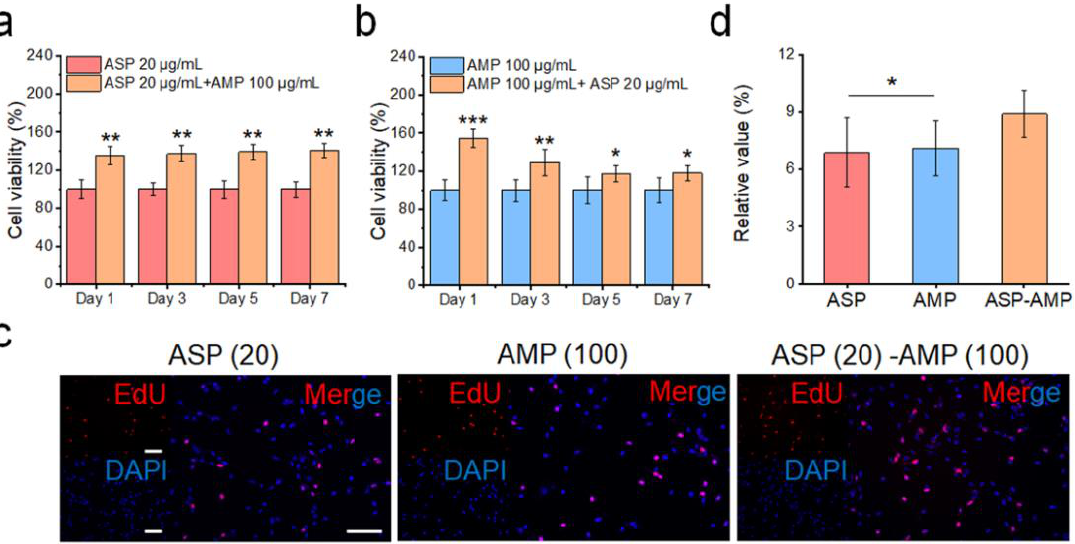
Figure 2. Combined treatment with both ASP and AMP enhanced the proliferation of NCTC clone 1469 cells. ( a ) The cell viability of hepatocytes treated with a combination of ASP and AMP compared to the separate use of ASP ( a ) or AMP ( b ) for 7 days ( n = 3). ( c ) Click-iT EdU proliferation staining of hepatocytes treated with ASP, AMP, and ASP-AMP for 3 days (scale bar = 100 µ m). ( d ) Relative expression rates of positive EdU staining ( n = 3). * p < 0.05, ** p < 0.01, and *** p < 0.001. As shown in the schematic diagram of 70% hepatectomy in mice, after median incision ( 1 (cid:13) ) the left ( 2 (cid:13) ) and middle ( 3 (cid:13) ) lobes of livers were resected in sequence, and the right and caudate ( 4 (cid:13) ) lobes of livers were left in residue (Figure 3a). After hepatectomy, Balb/c mice treated with ASP-AMP for 7 days were sacrificed, and after the harvest of the isolated liver tissue, a larger volume was displayed in the ASP-AMP group (Figure 3b). A higher liver to body weight ratio was observed in the ASP-AMP group (4.20%), being 1.34 times higher than that of control group ( p < 0.05, Figure 3c). Meanwhile, this ratio in the Sham group was 5.44%, indicating that the residual liver mass in the ASP-AMP group increased to 77.21% of the unresected liver. H&E analysis of the liver tissues showed no nuclear condensation or fragmentation in either group (Figure 3d). Strikingly, the ASP-AMP group exhibited increased hepatocyte proliferation after hepatectomy, as evidenced by increased Ki67 staining when compared with the control and sham groups ( p < 0.001, Figure 3d,e). ASP-AMP-treated mice displayed a potent reduction in plasma levels of alanine amino- transferase (ALT, 243.53 IU/L), aspartate aminotransferase (AST, 423.74 IU/L), and total bilirubin (52.61 IU/L) three days after hepatectomy, demonstrating the hepatoprotection of liver injury ( p < 0.05, Figure